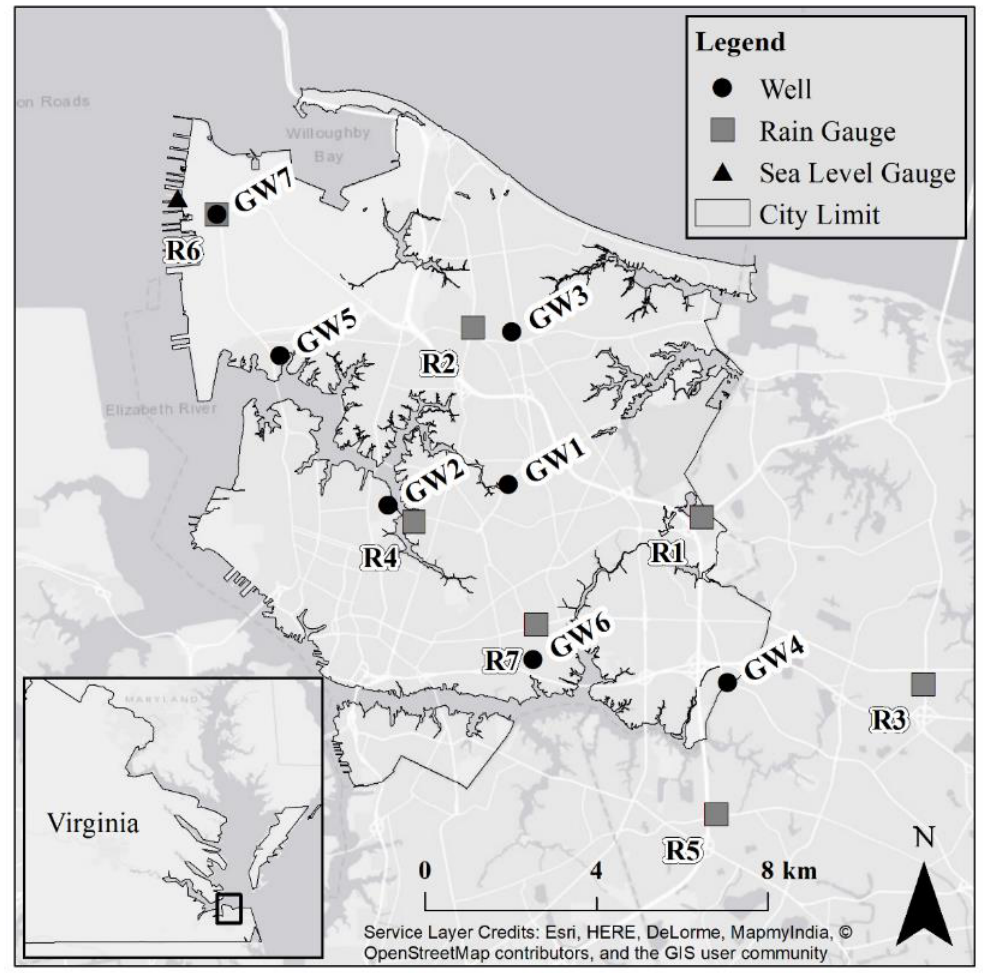
Figure 1. Location of gauges in Norfolk, Virginia.